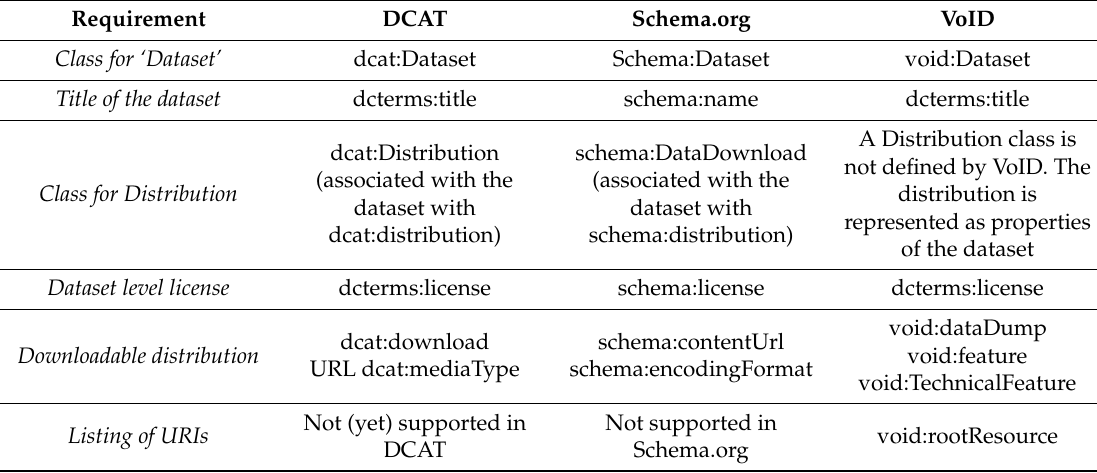
Table 1. The most relevant classes and properties for describing datasets and their